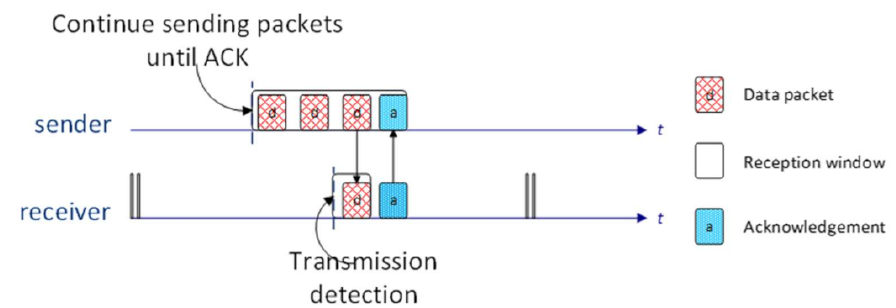
Figure A2. Link layer unicast in ContikiMAC.